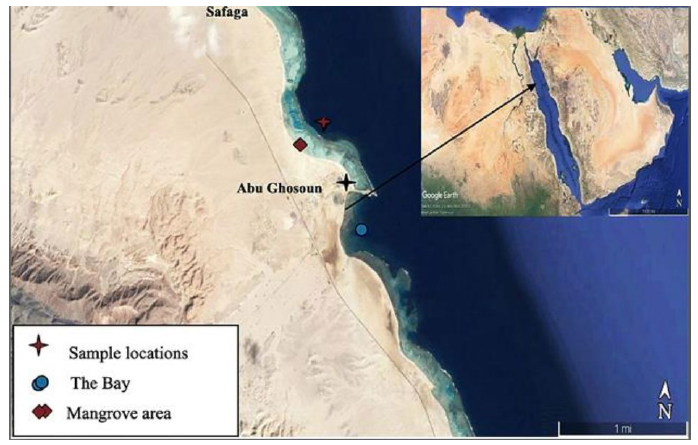
Fig. 1. The study area and sampling